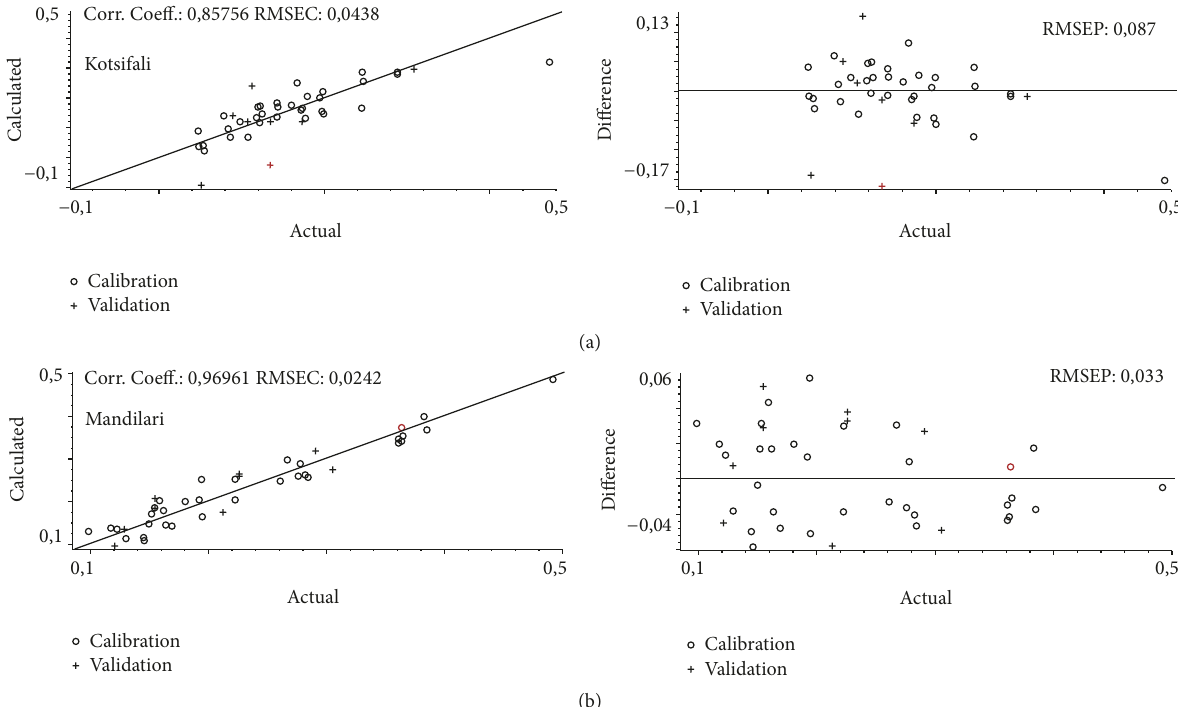
Figure 4: Correlation between the actual chemical age ii values and the values predicted by the model for Kotsifali (a) and Mandilari (b)